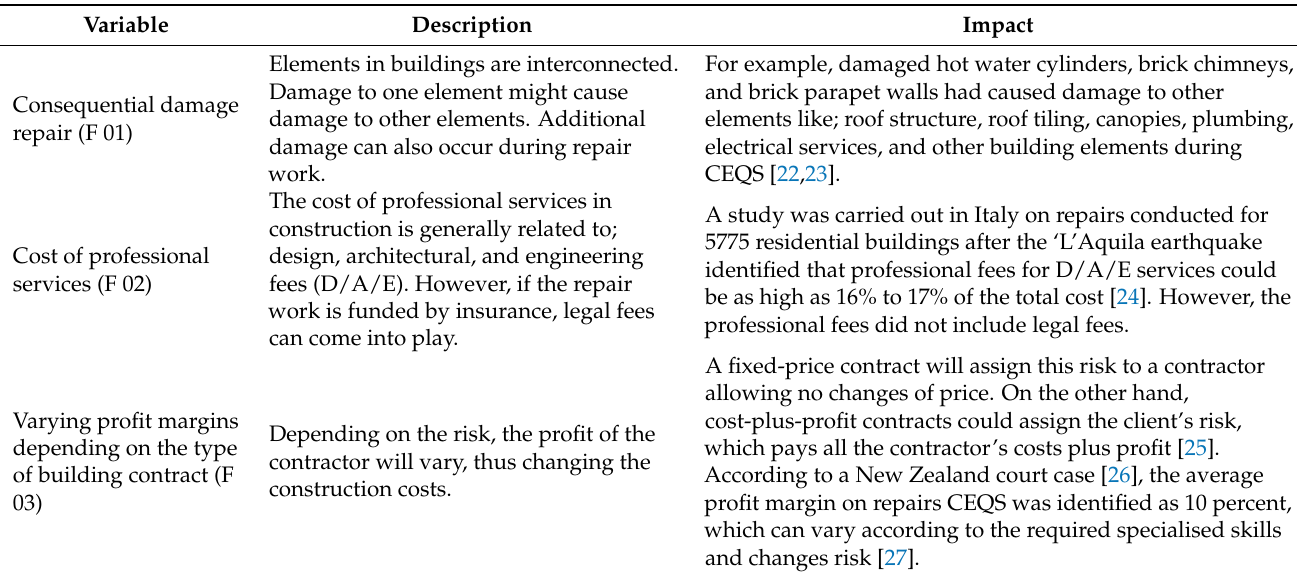
Table 1. Variables impacting